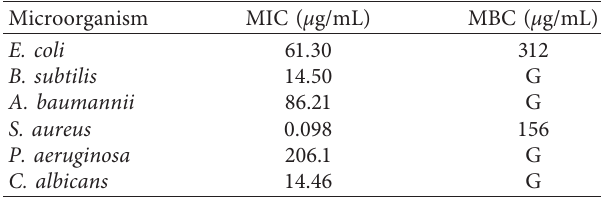
Table 6: The MIC and MBC of ZnO-NPs against microorganisms.